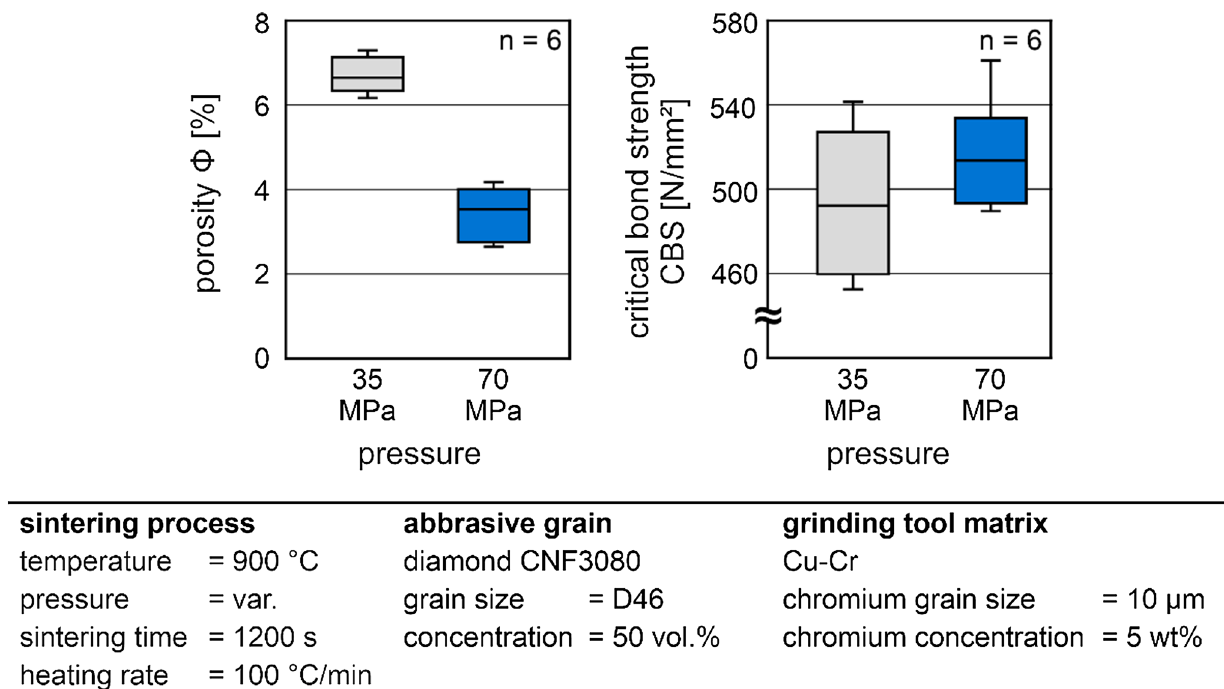
Fig. 5 Boxplot chart showing the effect of increased pressure on the porosity and the critical bond strength of the composite